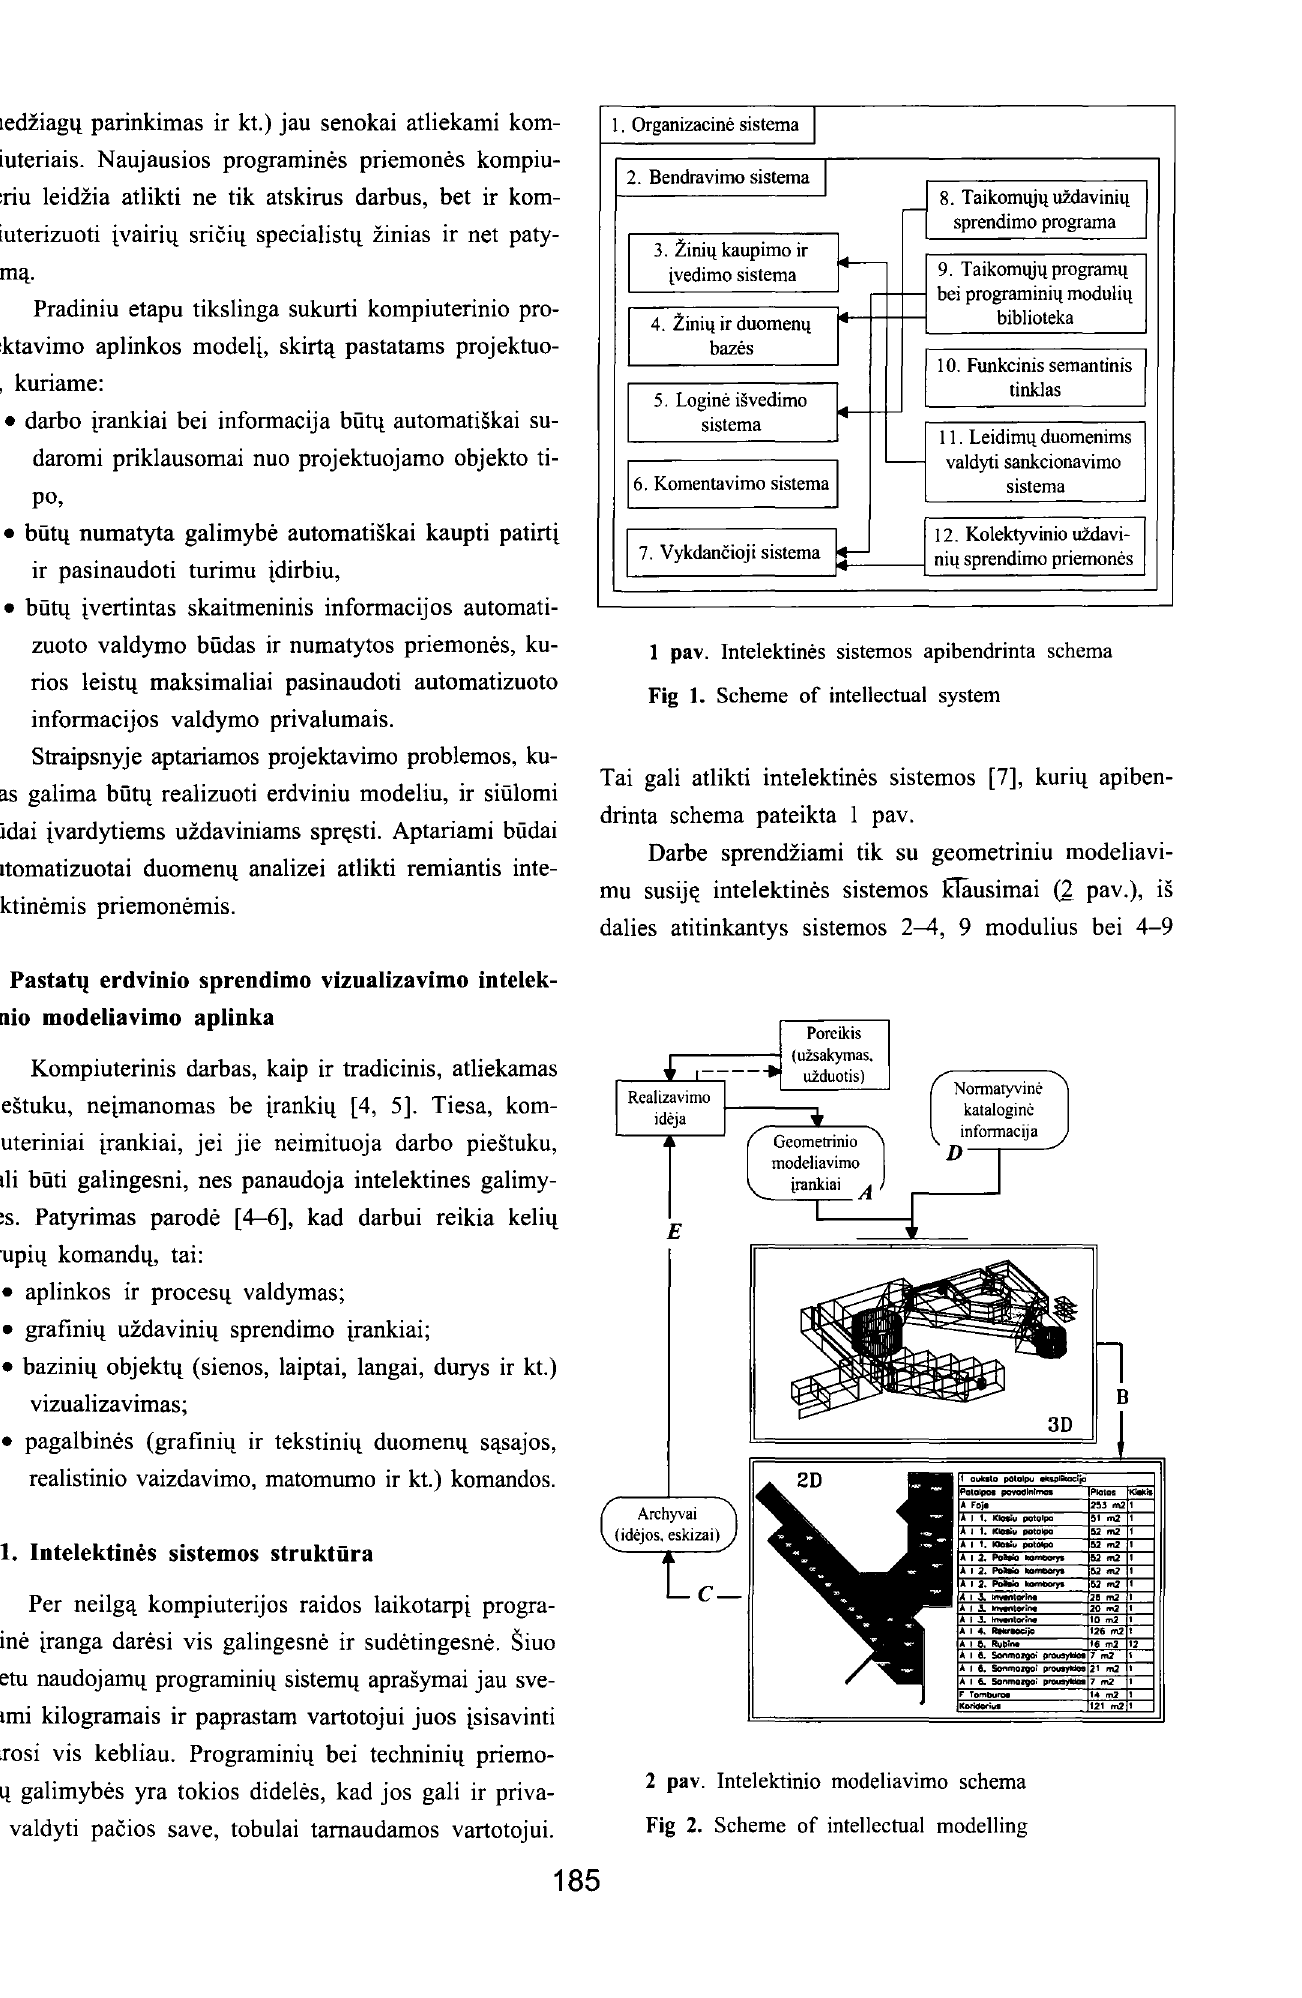
Fig 2. Scheme of intellectual